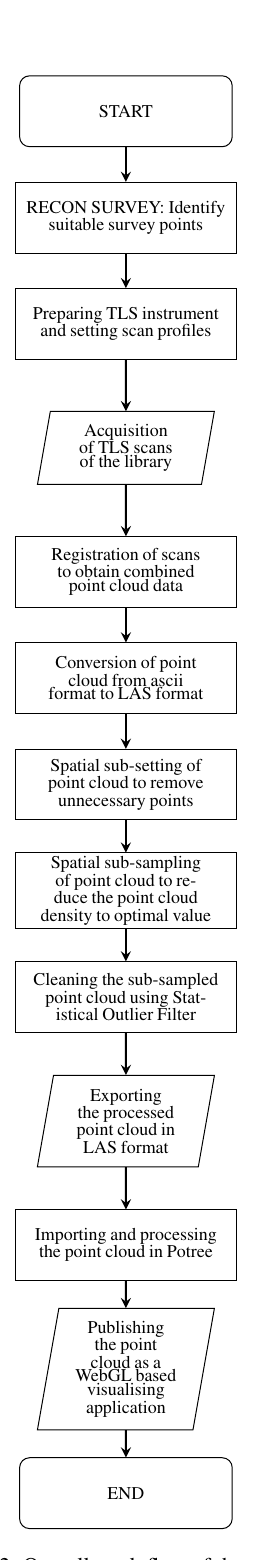
Figure 2. Overall work flow of the